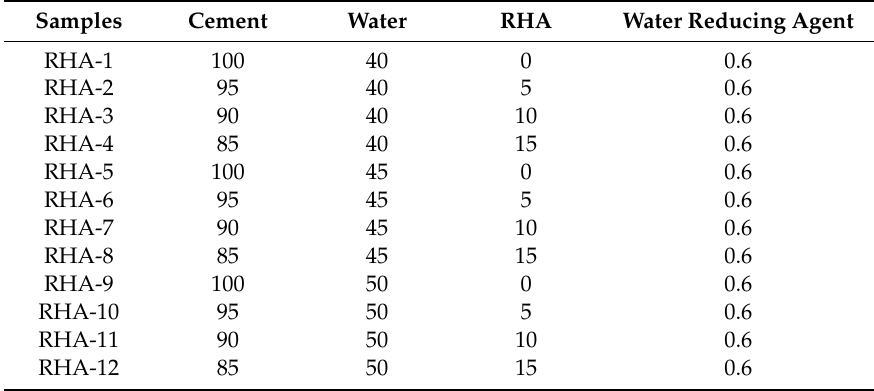
Table 3. Mixing proportion of fresh cement